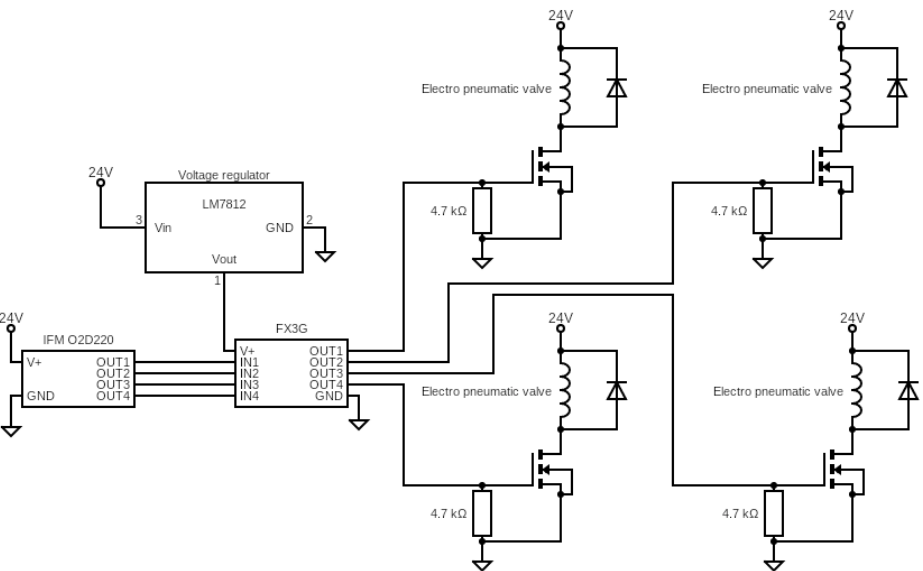
Figure 13. Circuit diagram of the second sorting stage.